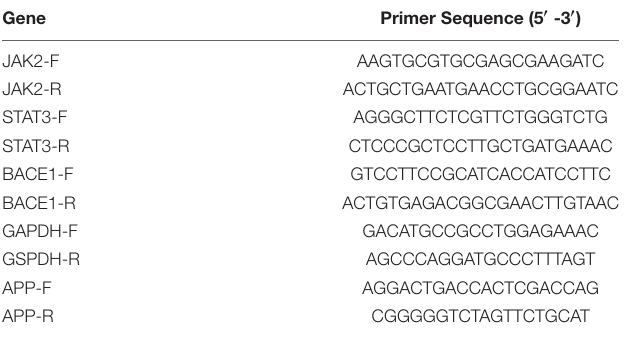
TABLE 1 | Primer sequences used in the